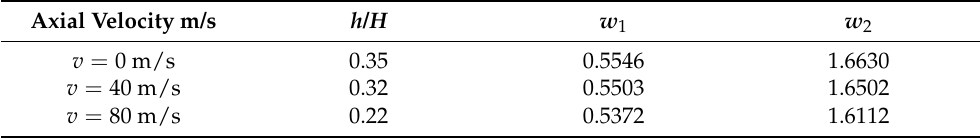
Table 1. Natural frequency and thickness ration of SMA to base beam.